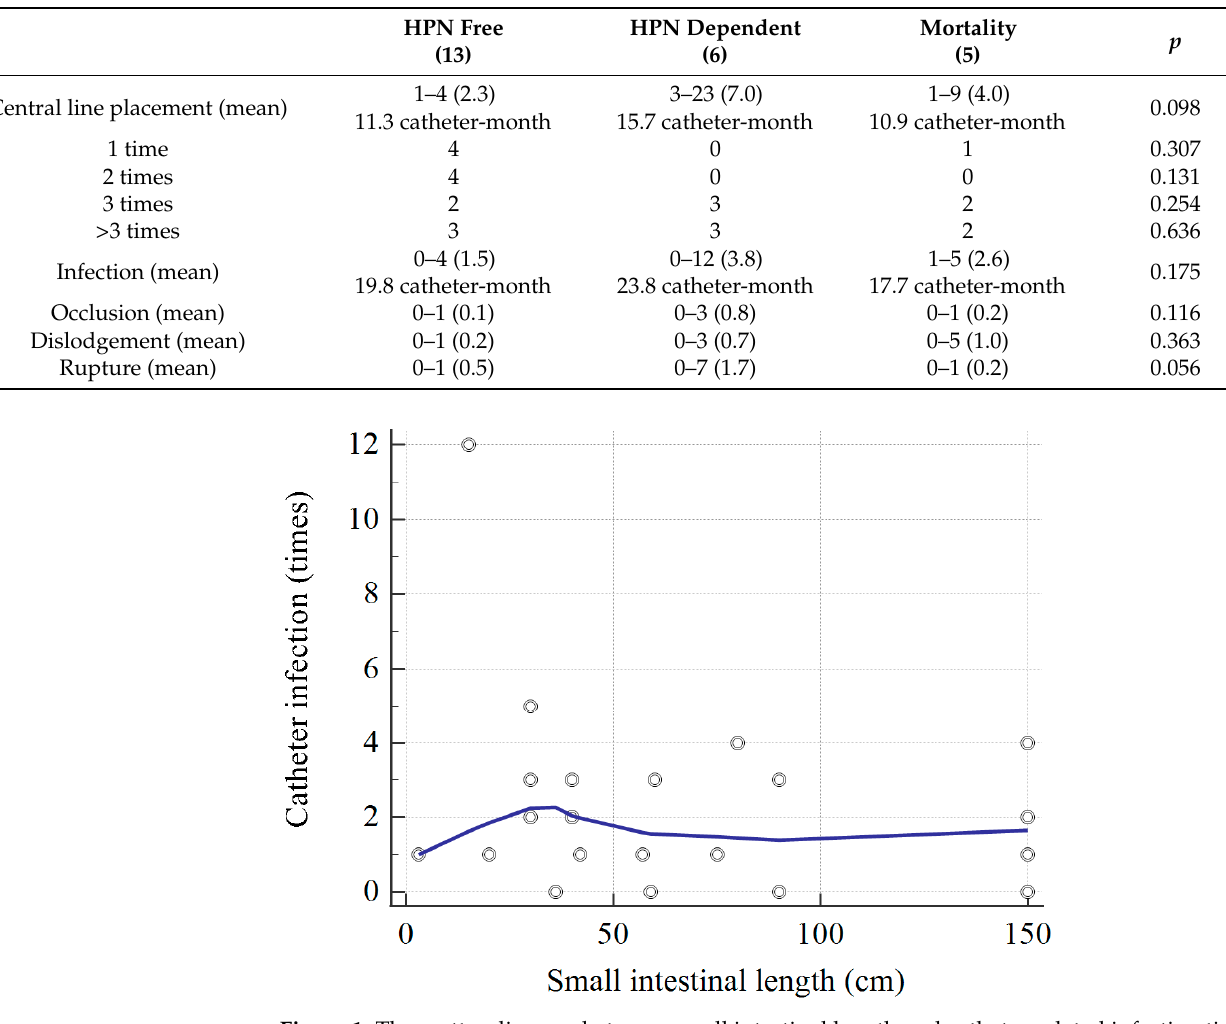
Figure 1. The scatter diagram between small intestinal length and catheter-related infection times. Correlation coefficient, r = − 0.237 ( − 0.584 to 0.183) and p = 0.263. Trend line by locally weighted scatterplot smoothing and span = 60%.